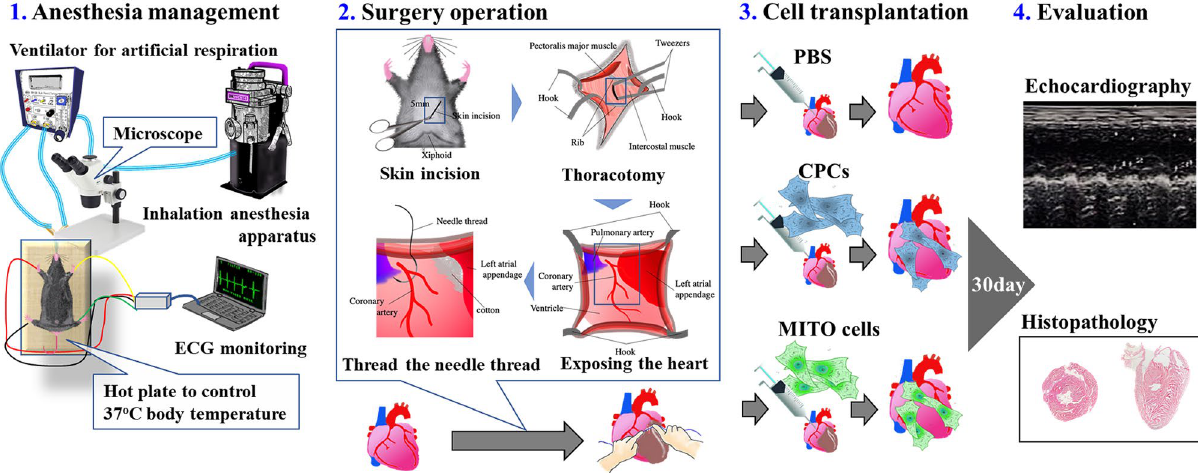
Figure 1. Experimental protocol for evaluating the therapeutic effect with respect to the ischemic cardiomyopathy mouse model after the transplantation of MITO cells. Evaluation of treatment of heart failure by transplanting cells to an ischemic lesion of ischemic cardiomyopathy mouse model (see the Movies 1, 2 for the